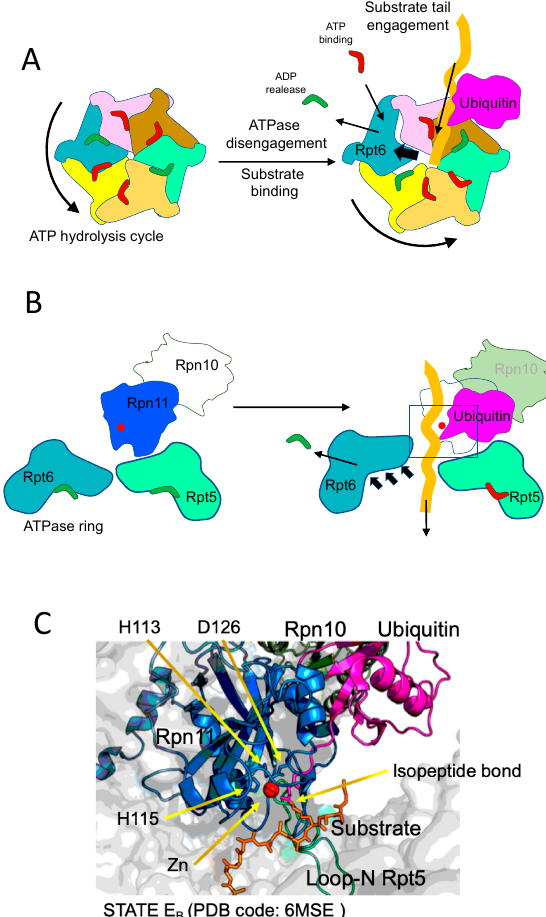
Figure 3. Representation of substrate engagement and deubiquitination state. ( A ) Top view of the ATPase ring similar to images provided by De La Peña et al. [13] and Dong et al. [27]. The transition from the inactive state (left) to the initial engagement of the substrate (right) is shown. ATP hydrolysis, ADP release and Rpt6 motion trigger the opening of the ATPase pore, facilitating the engagement of the tail of the substrate. ( B ) Side view of the process shown in A, with the representation of the movement back of Rpt6, generating additional space in the pore. A substrate in the process of engagement is included, simulating a formation of the E B state. The rectangle included in the right image defines the space zoomed in the panel below. ( C ) Ribbon representation of the Rpn11 active site in the presence of a ubiquitinated substrate. Key components are included: catalytic Zinc (red), active-site Rpn11 (blue) residues (His113, His115 and Asp126), substrate (orange) and ubiquitin (pink) linked by means of an isopeptide bond, Rpn10 (dark green) and Rpt5 loop (light green). The pdb coordinates used to display this image in PyMOL: 6MSE (corresponding to E B state, [27]). Abbreviations: ATP, adenosine triphosphate; ADP, adenosine diphosphate; Rpt, regulatory particle ATPase subunit; Rpn, regulatory particle non-ATPase subunit; pdb, protein data